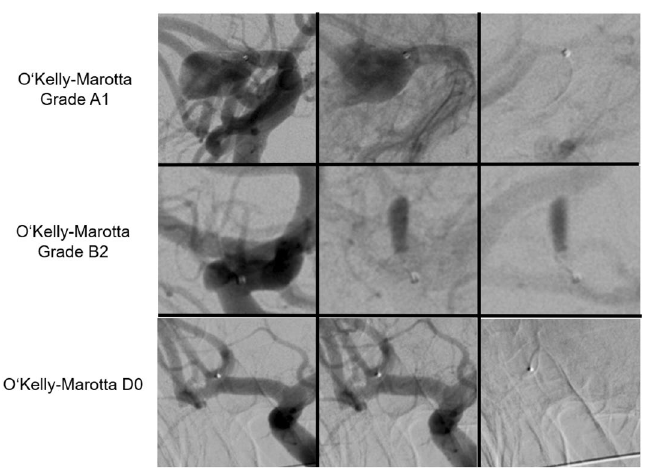
Figure 3. Angiograms of different outcomes in the O’Kelly Marotta grading scale immediately after Contour device